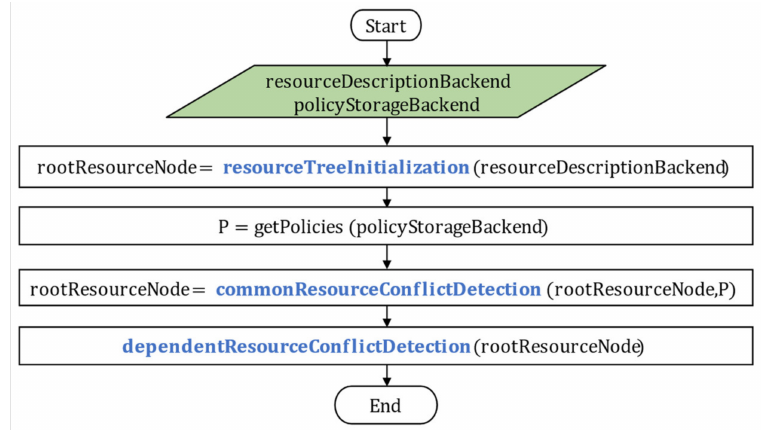
Figure 8. CAPA Algorithm Flow